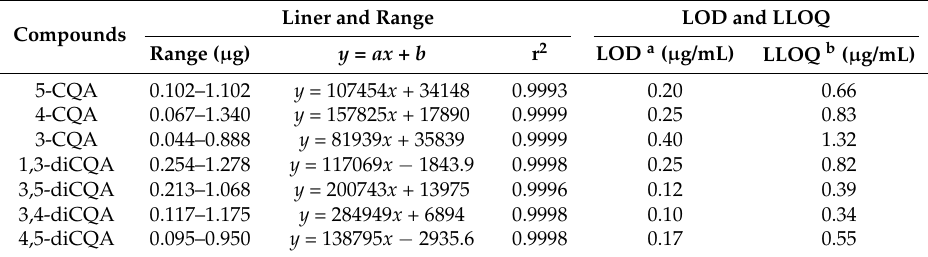
Table 2. Precision and repeatability for the assay of seven CQAs.